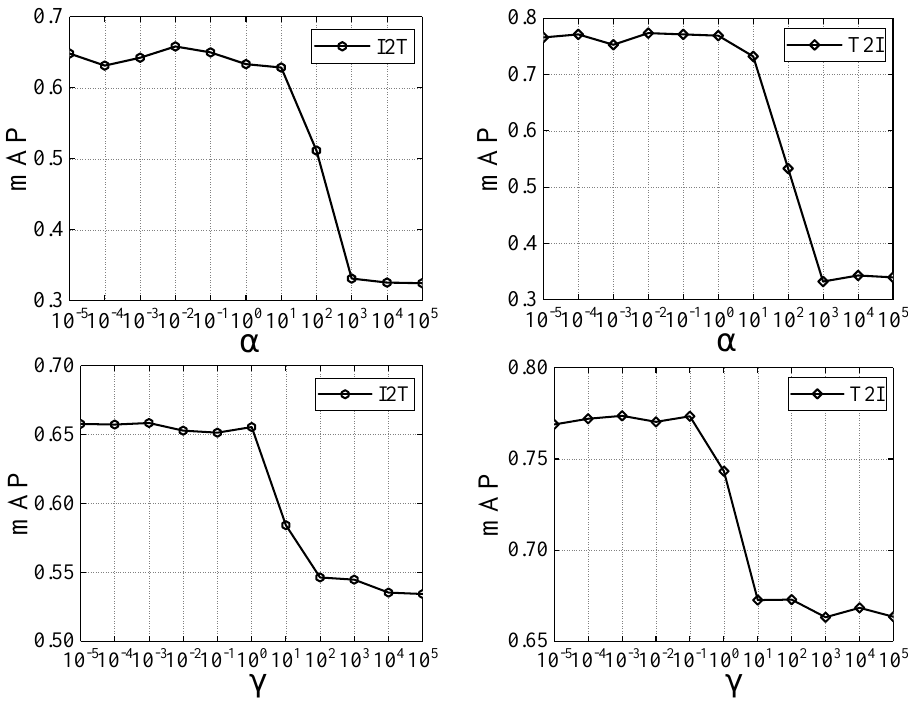
Figure 4. Parameter sensitivity analysis of α and γ on NUS-WIDE dataset with 64 bits.